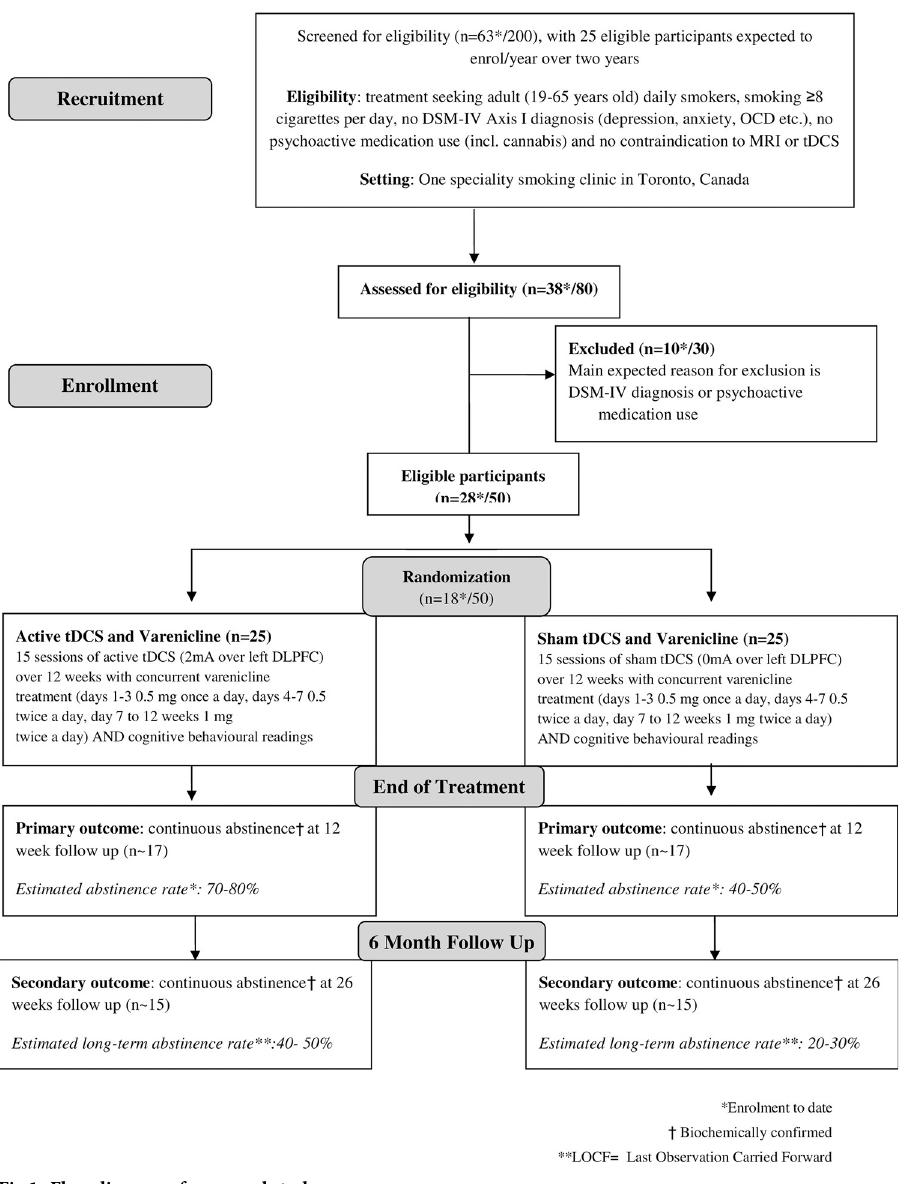
Fig 1. Flow diagram of proposed